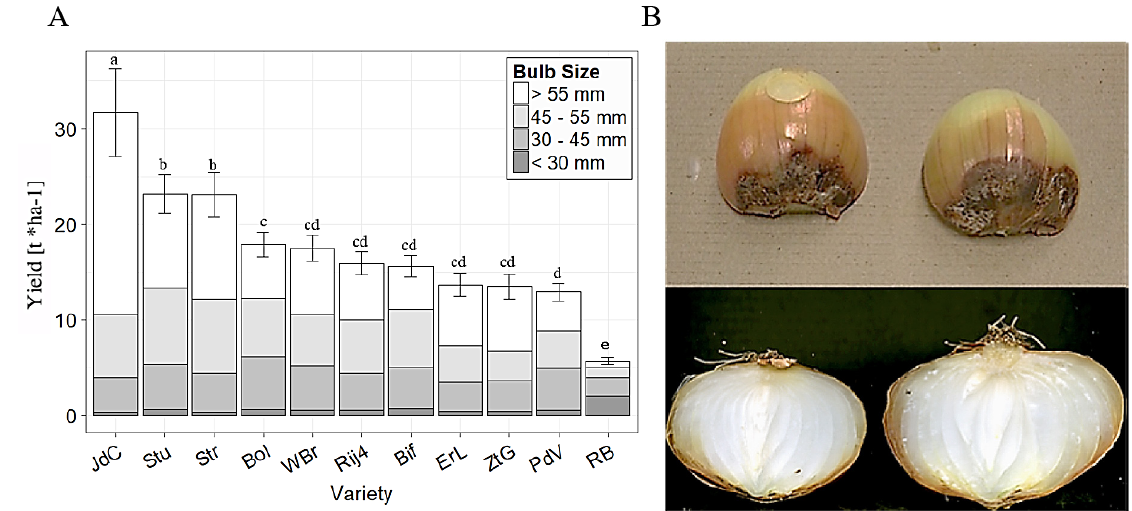
Fig. 2: A: Onion total yield and bulb size. Stacked bar graph in which the overall height of the bar indicates the total yield, data are mean ± SE, n = 4, letters indicate significant differences among the varieties determined by “Post-hoc” test (p < 0.05). The height of each segment (coded as shown in the figure) represents the amount of bulbs sorted by size in a variety. Jaune des cévennes (JdC), Stunova (Stu), Sturon (Str), Bolstar (Bol), Wiener Bronzekugel (WBr), Rijnsburger 4 (Rij4), Birnförmige (Bif), Erfurter Lager (ErL), Zitauer Gelbe (ZtG), Paille des Vertus (PdV), Red Baron (RB). B: Diseases and disorders observed during curing and storage of onion bulbs (Jaune des